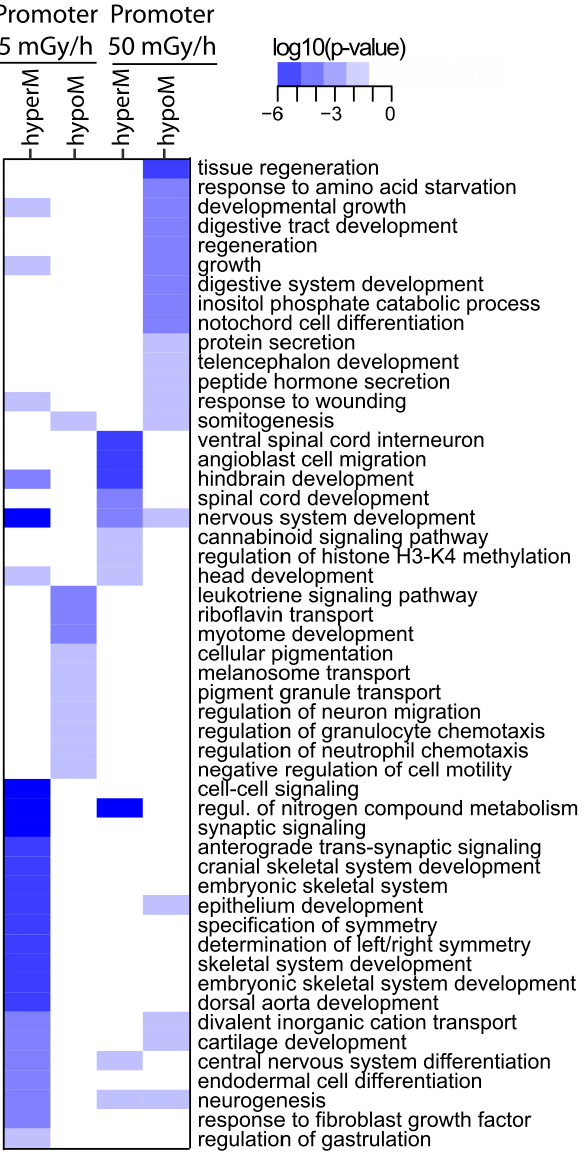
Figure 8. Heat map of GO enrichment of gene promoter displaying significant methylation changes. DMR with permutation p -values < 0.05 and located less than 3 kb from the TSS were used. Dose rates and methylation state are indicated at the top. Colours indicate the enrichment p -values obtained from Fisher’s exact